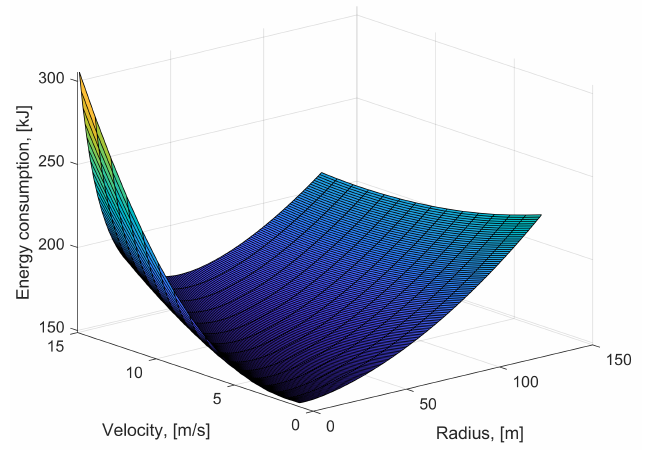
Figure 7. 3D graph of energy consumption of circular flight with respect to radius and flight